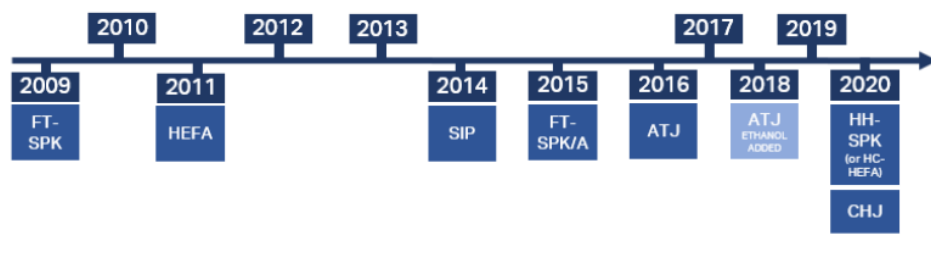
Figure 6. Timeline of D7566 approved pathways [66].